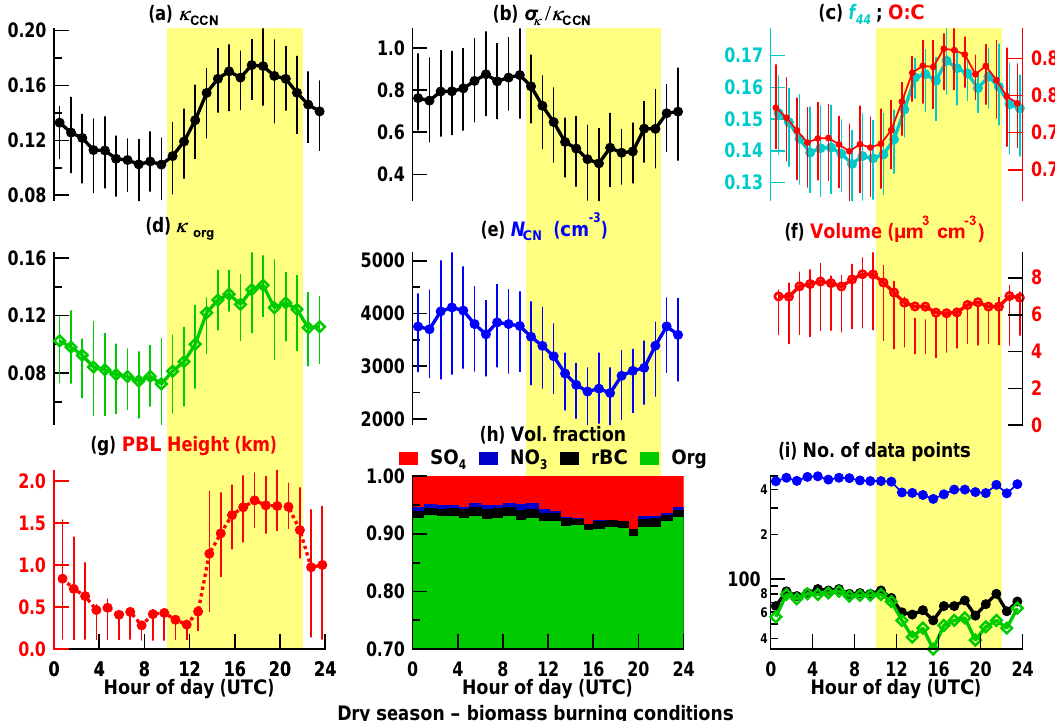
Figure 7. Diel variations of aerosol properties and meteorological parameters for local biomass burning air masses during the dry season (analogous to Fig. 3).